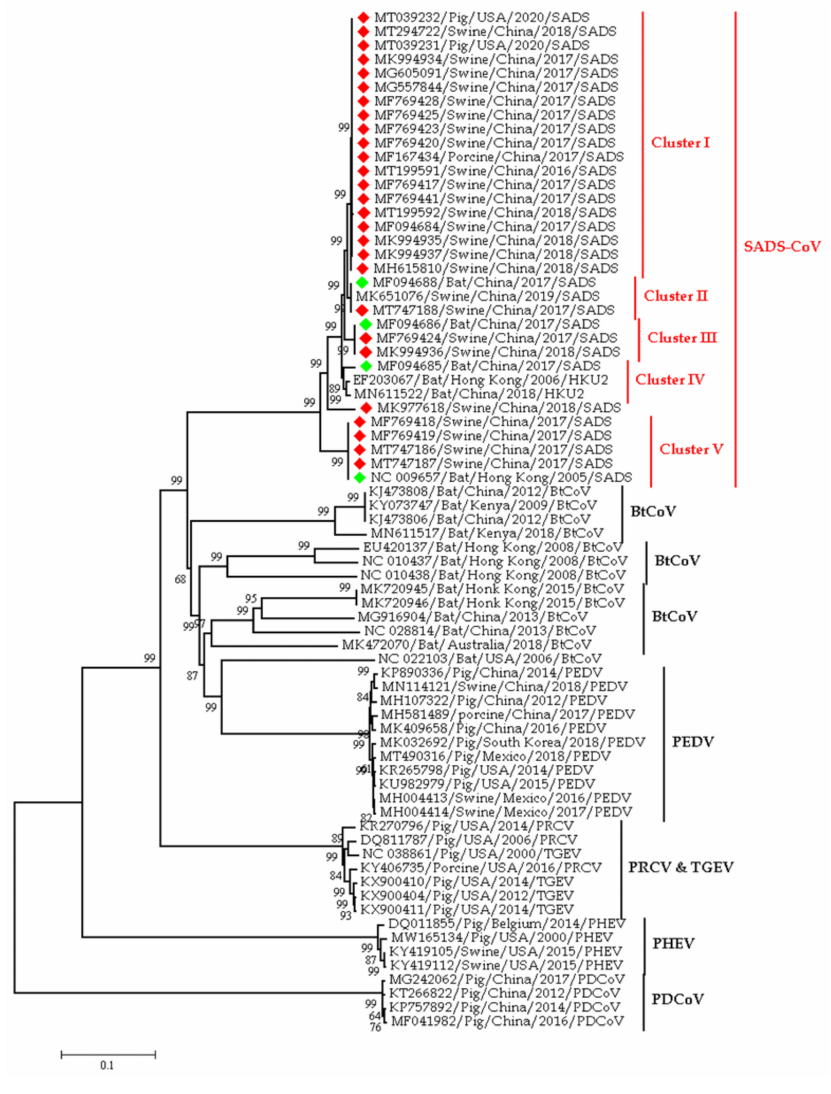
Figure 3. Phylogeny of swine coronaviruses detected to date in the world; the red blocks denote sequences from pigs, whereas green blocks denote sequences from bats. This phylogenetic tree representing the evolutionary relationship between representatives Alpha CoV originated from Swine host. The main purpose was to explain the evolutionally origin of SADS-CoV from Pig and Rhinolopoid bats. From this point of view, we have taken various representative- Bat and Pig originated SADS-CoV sequences on the basis of time and space. Besides, we also know that pig is infecting multiple types of alpha and beta coronaviruses like PEDV, PRCV, TGEV, PHEV and PDCoV. So, we selected representative sequences of swine infecting different types of coronaviruses based on different time and space to understand the phylogenetic relatedness of diverse swine